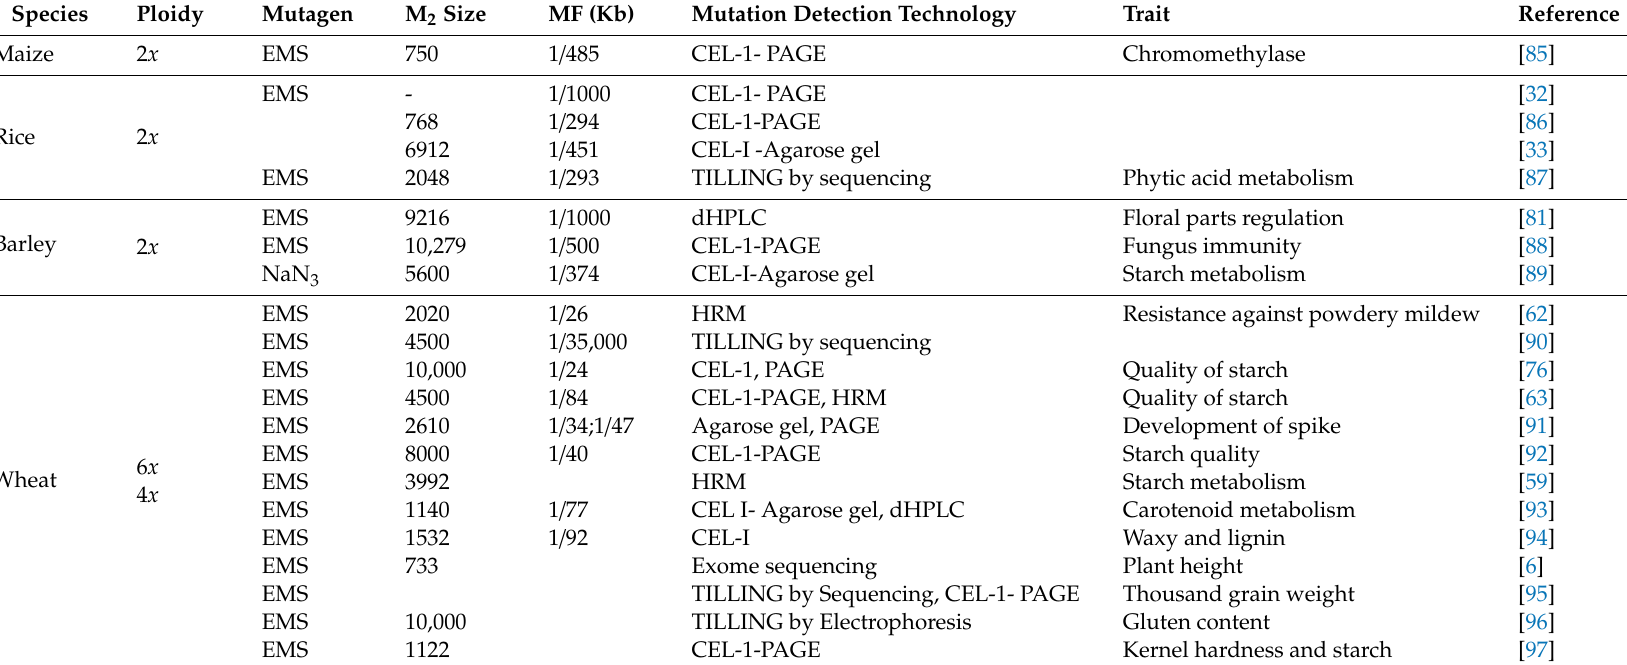
Table 2. Overview of di ff erent TILLING approaches in various cereal